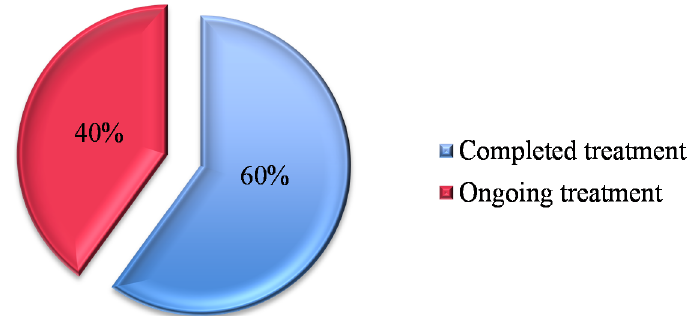
Figure 1. Refractory coeliac disease type 2 on treatment.